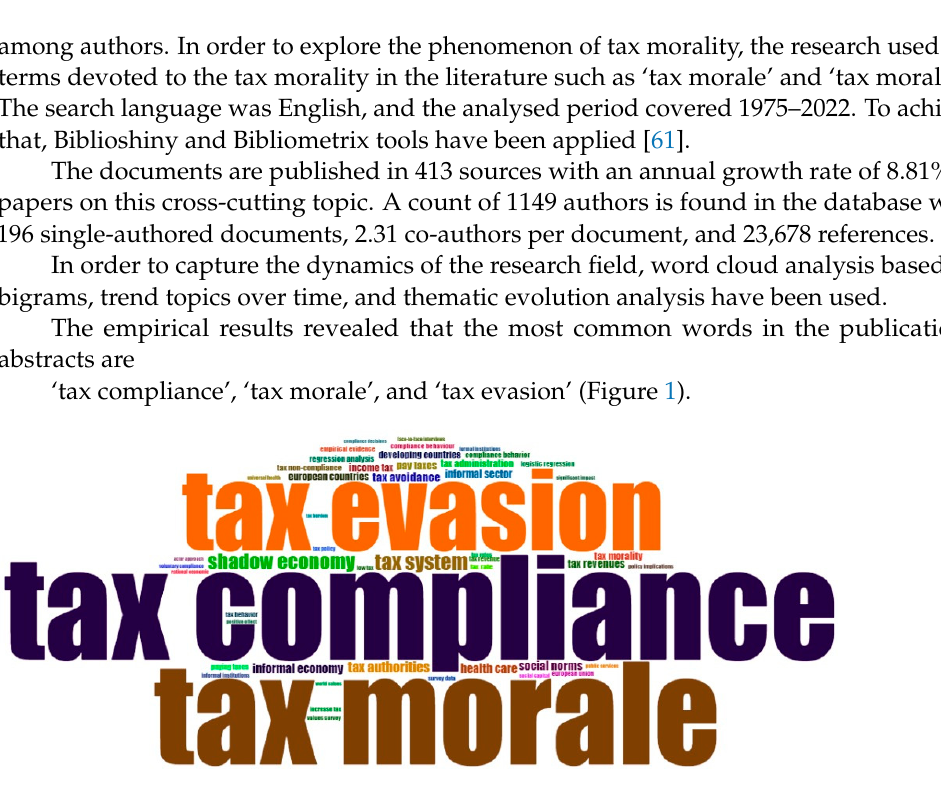
Figure 1. Bigrams of abstracts’ wordcloud.